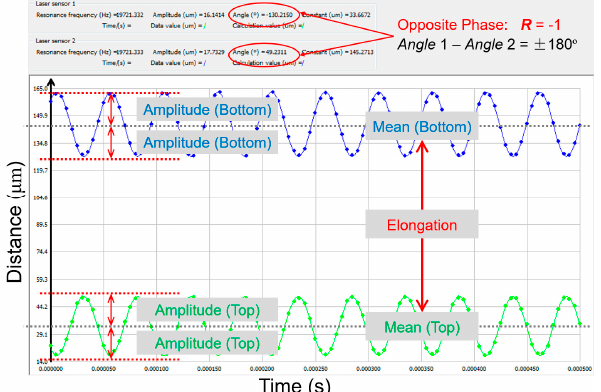
Figure 3. Original vibration wave obtained from laser sensor ( R = − 1, f = 20 kHz).